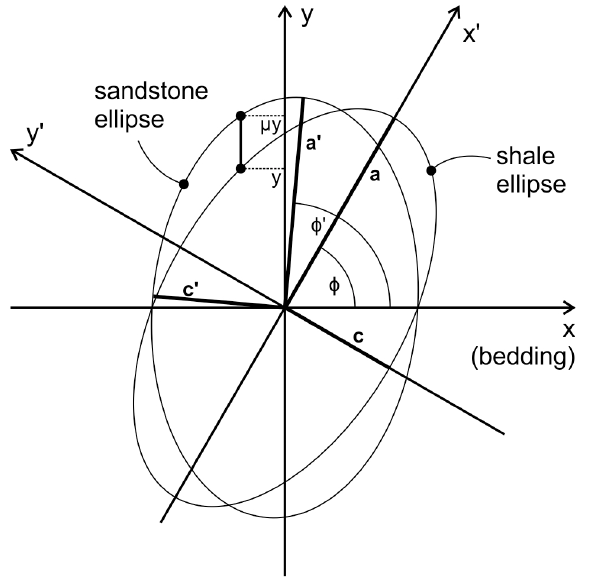
Figure 5. Geometry of the strain ellipses of the sandstone and shale layers of Fig. 1, which are rotated ellipses with reference to the Cartesian x, y coordinates. µ is the ratio between the volumetric stretches of both